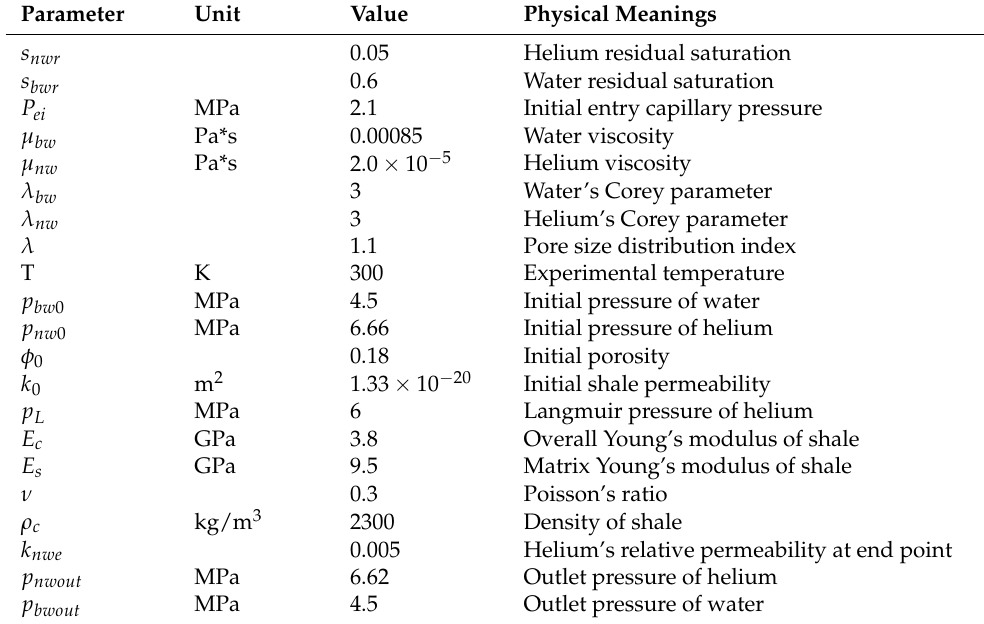
Table 2. Computation parameters for gas breakthrough test.